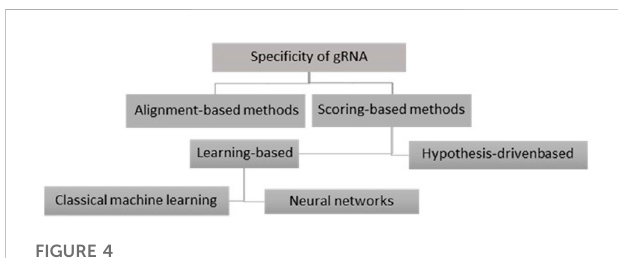
FIGURE 4 Basic methods to predict the speci fi city of CRISPR gRNAs.